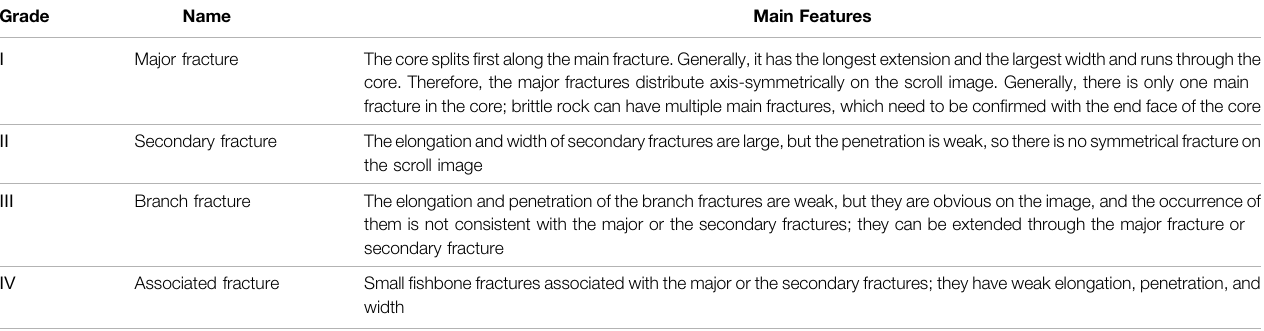
TABLE 1 | Post-fractured core fracture classi fi cation method.